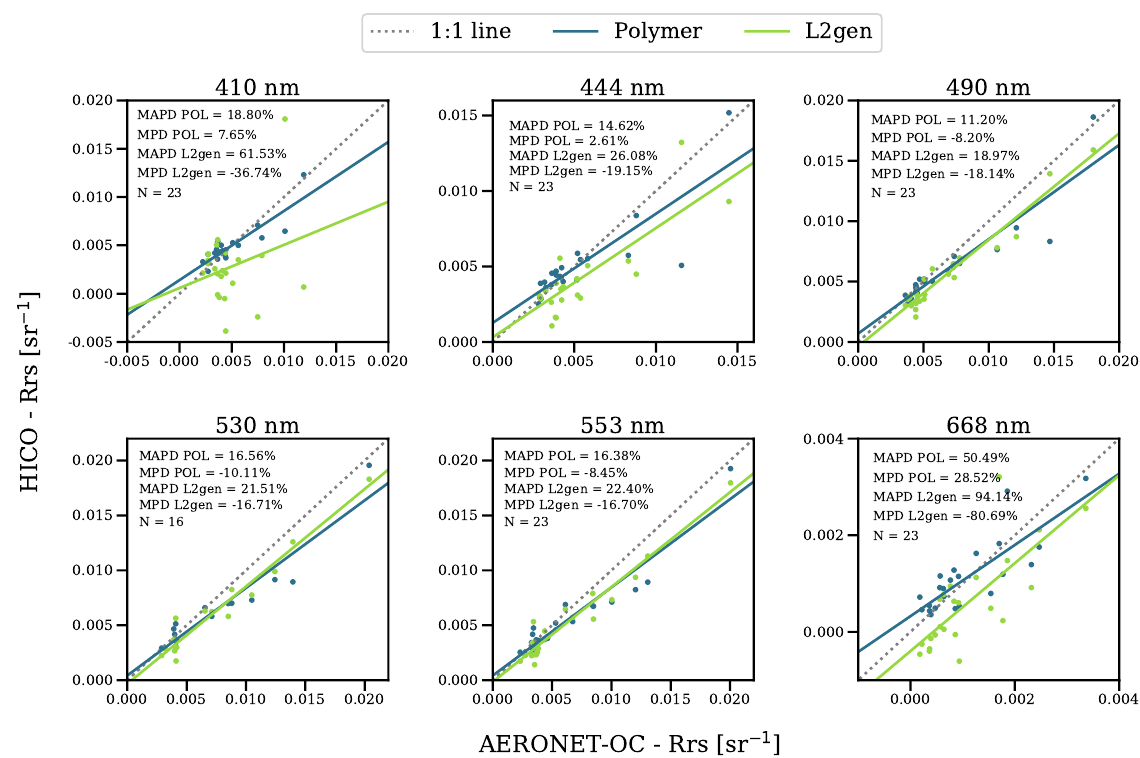
Figure 4. Scatterplots of the AERONET-OC-Rrs versus Polymer (blue) and L2gen (salmon) HICO-Rrs at Venice AERONET- OC; coincident match-ups.